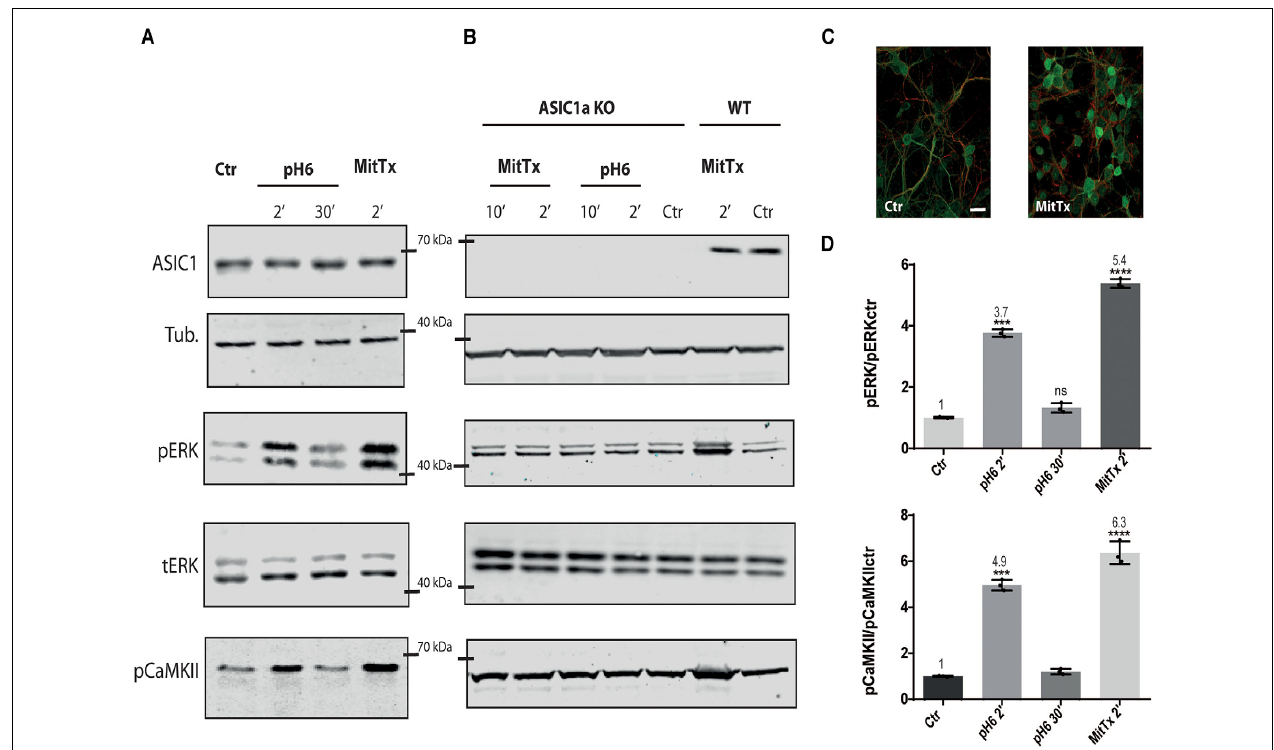
FIGURE 1 | Non-proton activation of ASIC1a in striatal neurons. Representative membranes of lysates from 7 DIV wild type (A) , and ASIC1a knockout (B) C57 mice striatal neuronal cultures were incubated with MitTx and compared to treatment with pH6 solutions for the time indicated (2, 10, or 30 min). The detection was performed with anti ASIC1, tubulin (Tub), phospho ERK (pERK), total ERK (tERK), or phospho CaMKII (pCaMKII) antibodies, and Licor secondary antibodies. (C) Examples of images of striatal cultures used and treated with MitTx and stained with tubulin (red) and phosphoERK (green) antibodies and secondary Alexa fluor antibodies, 60 × objective used. Scale bar 10 µ m. (D) Result of the bands detected in (A) for pERK/ERKt levels relative to control samples showing an increase in both, pH6 or MitTx treatments and the same pattern of increase for pCaMKII. Notice the lack of effect in ASIC1a knock-out derived cultures. (A) Notice that plots are the result of the signal intensity of the bands detected for each antibody, and tERK and tubulin are used as loading controls between loaded samples. Data are presented as the mean ± SEM ANOVA and Dunnet post hoc test for treatments against the control were performed, mean values above bars; n = 3 membranes, **** p < 0.0001; *** p 0.0001–0.001; ns: no significant differences. Mean values expressed relative to control ( Ctr ) levels ± SEM are as follows: for pERK/tERK: pH6 2’ 3.77 ± 0.07; pH6 30’ 1.32 ± 0.09; MitTx 2’ 5.39 ± 0.08. For pCaMKII/Tub: pH6 2’ 4.97 ± 0.14; pH6 30’ 1.20 ± 0.07; MitTx 2’ 6.37 ±